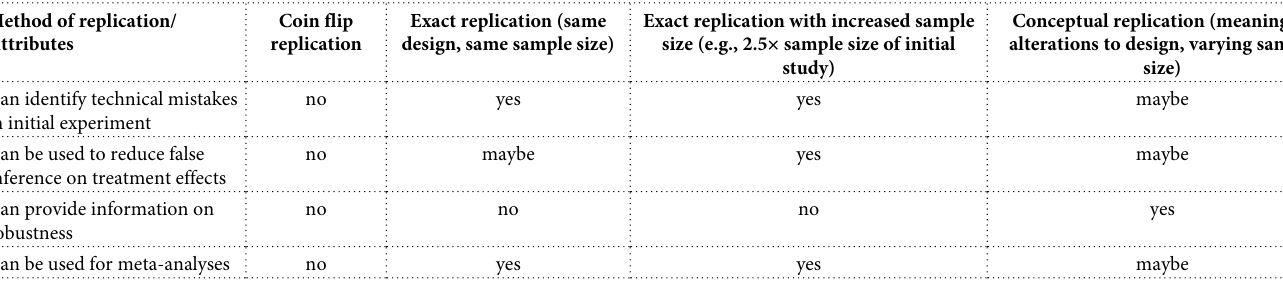
Table 1. Attributes and applications of different methods of replication. Method of replication/